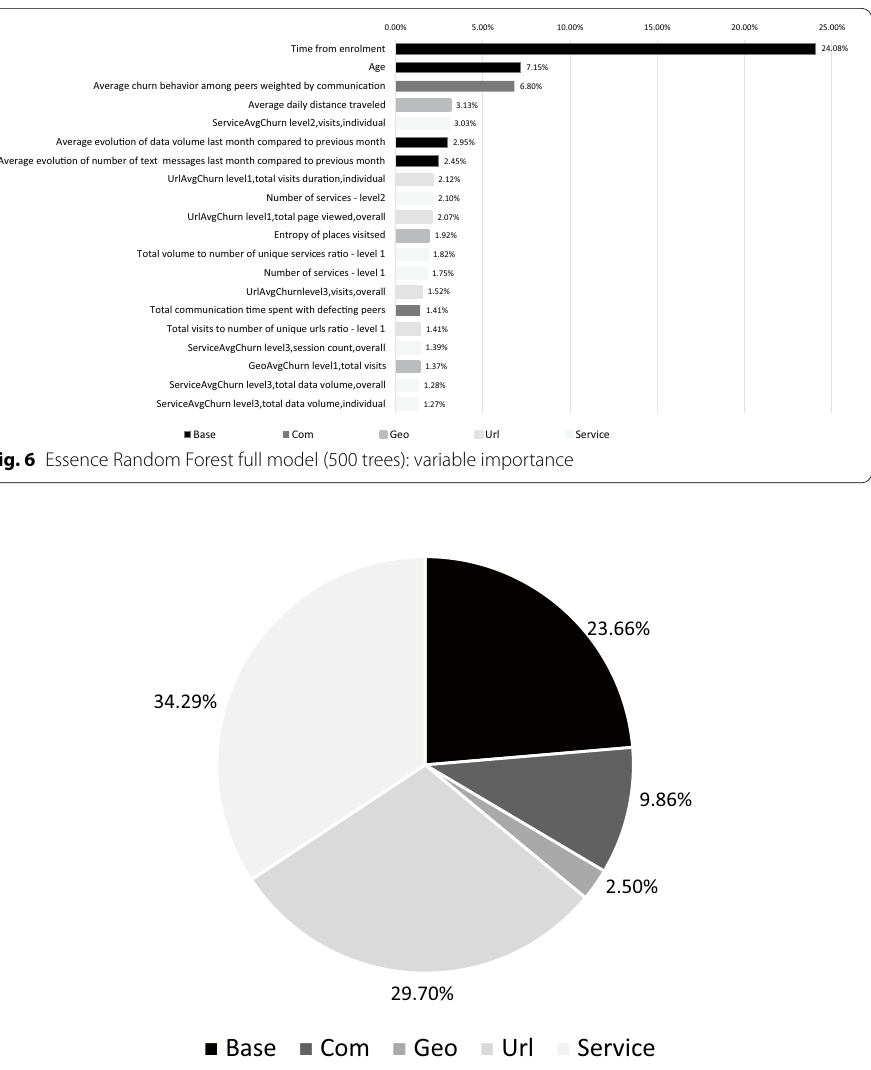
Fig. 7 Variable importance aggregated by metric categories for ERF full model (500